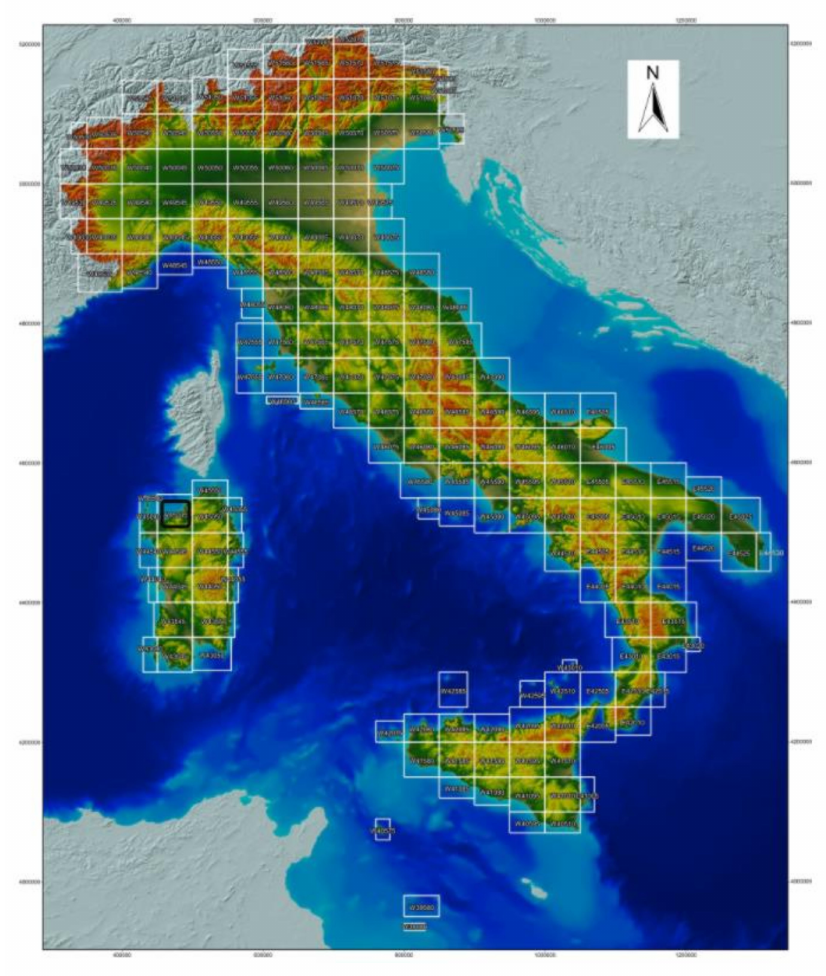
Figure 14. Digital elevation model